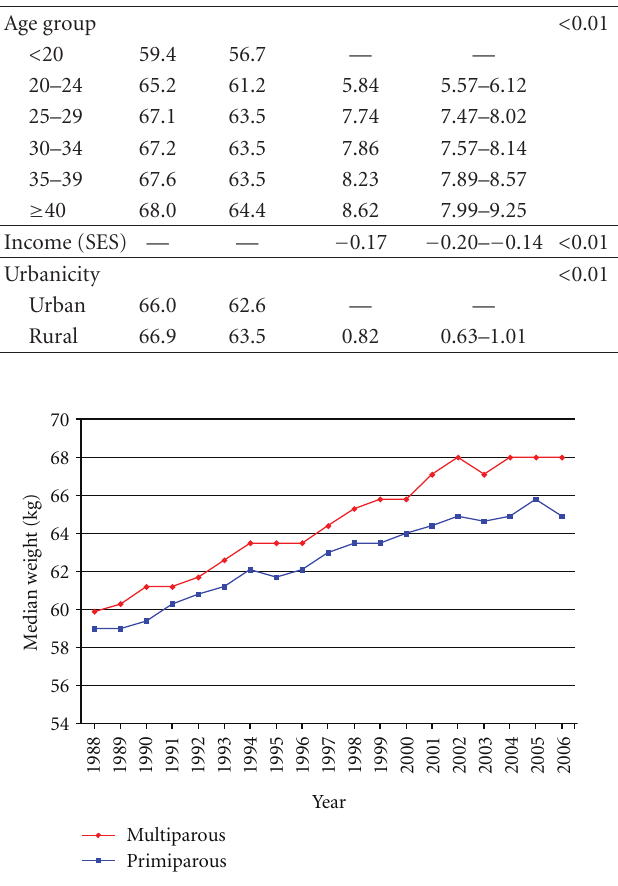
Figure 1: Median prepregnancy bodyweight, primiparous, and multiparous women, 1988–2006.